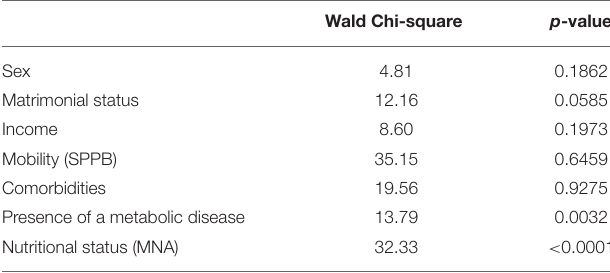
TABLE 2 | Results of the multivariate logistic regression analysis (dependent variable: weight status): Wald Chi-square and p value associated with each independent variable (Likelihood ratio = 166.41; p < 0.001).